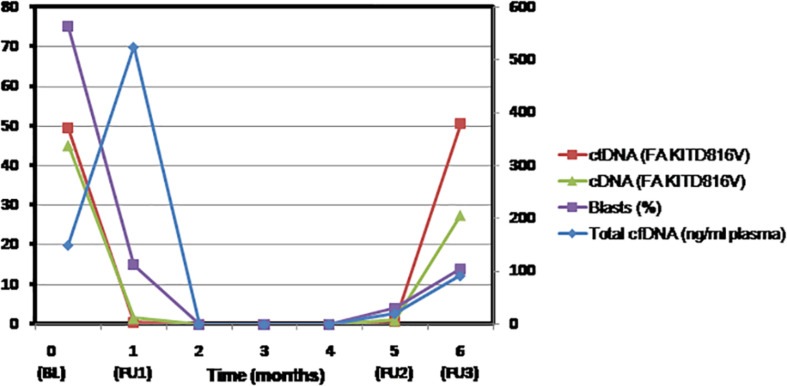
The fractional abundance of KIT mutation in circulating tumor-derived DNA but not the levels of plasma cell free DNA represent residual AML better and may predict early relapse. Molecular monitoring of plasma cell-free DNA and bone marrow samples of AML patient was performed by droplet digital PCR at the indicated time points. Shown in the line graph are blast percentage (violet square), total plasma cfDNA concentration in nanograms per milliliter plasma (blue diamond), fractional abundance of KIT D816V mutation in cfDNA (red square), and bone marrow (green triangle) at baseline (BL = Day 0), MRD assessment (FU1 = Day 30), clinical remission (FU2 = 5 months), and after consolidation and relapse (FU3 = 6 months). BL, baseline; cDNA, complementary DNA; cfDNA, cell-free DNA; ctDNA, circulating tumor-derived DNA; FA, fractional abundance; FU, follow-up; MRD, measurable residual disease.